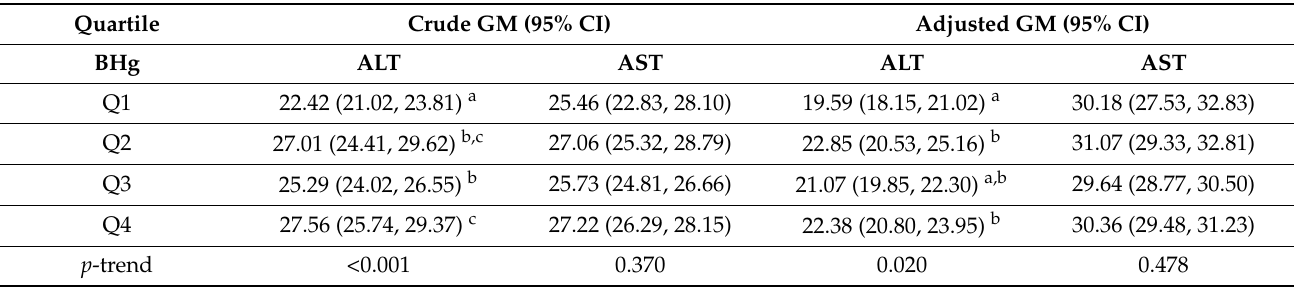
Table 3. Serum AST (IU/L) and ALT (IU/L) by quartile of blood mercury ( µ g/L) before and after adjustment of covariates #, KoNEHs 2015–2017.